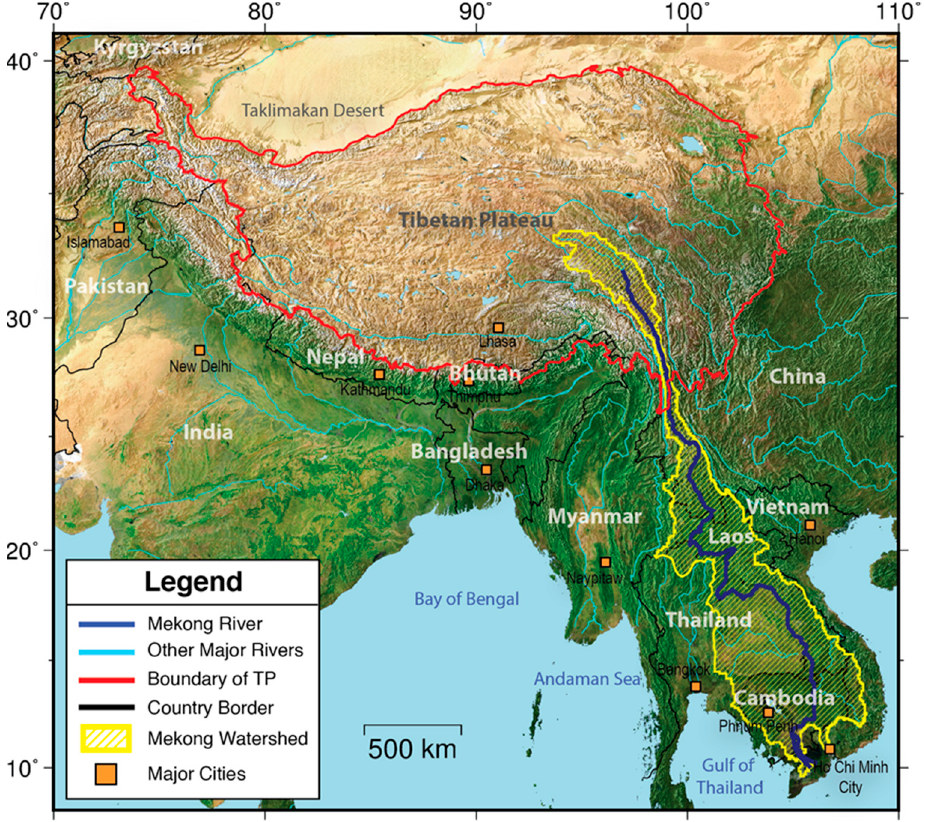
Figure 1. Locations of the Mekong River (navy blue) and its watershed (yellow shaded area). The river was originated from the southeast of the Qinghai-Tibetan Plateau (boundary depicted by red borders). The background used TrueMarble imagery, with terrain elevation enhancement by NOAA ETOPO1 global digital elevation model (DEM). This figure was plotted using the Generic Mapping Tool (GMT) version 5, which is available from [2]. GMT is an open source tool collection for manipulating geographic and Cartesian data sets [3].